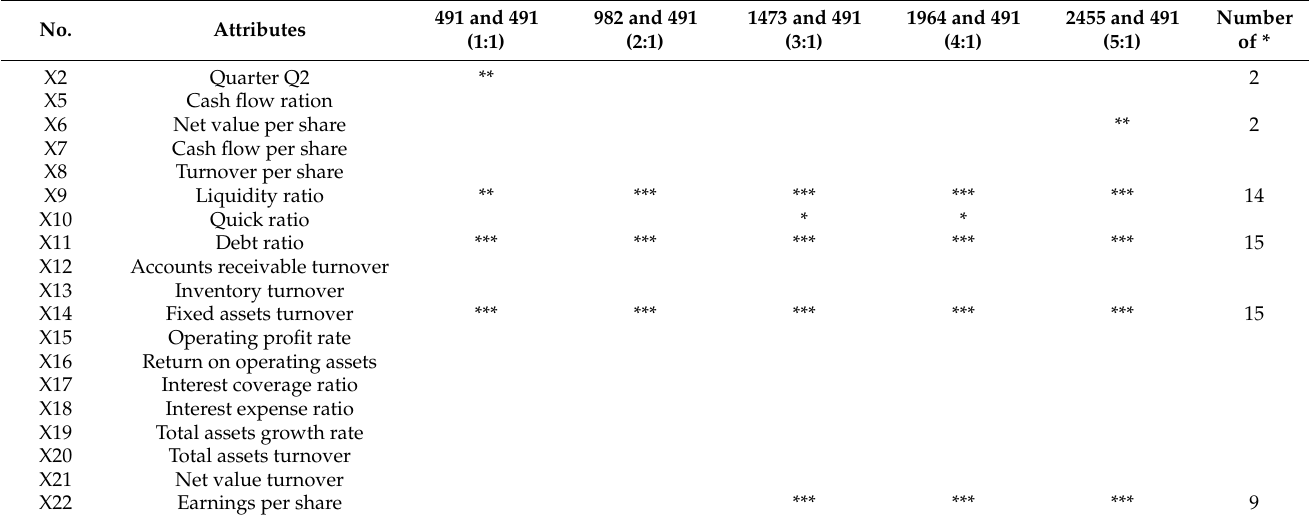
Table 24. Statistics of logistic analysis results for normal vs.